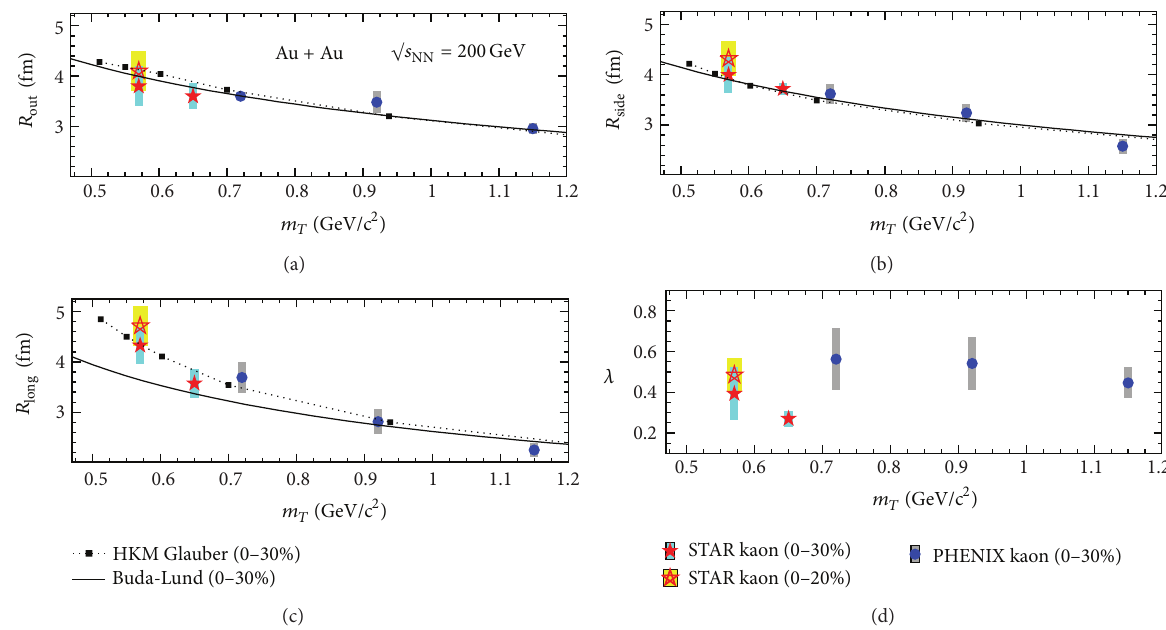
Figure 4: Transverse mass dependence of Gaussian radii (a) 𝑅 = 200 GeV. The results from STAR [72] and PHENIX [73] are compared to the calculations in hHKM model 𝐴𝑢 + 𝐴𝑢 collisions at √𝑠 𝑁𝑁 (dotted